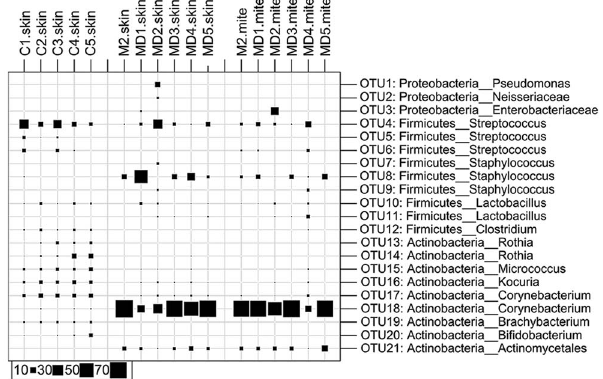
Figure 5. Microbial composition of skin samples and isolated scabies mites collected from severely scabies infested crusted sites (week 10) and control animals. Bubble plot of the taxonomic profile as calculated for the OTU level. Only OTUs with a relative abundance of $ 2% in at least one sample are shown. Each OTU is denoted with the taxonomic classification according to the RDP Classifier (confidence value $ 0.6). The taxonomic composition between the healthy skin and the mite containing skin as well as the washed mites is differing mainly based on the relative abundance of Corynebacteria .